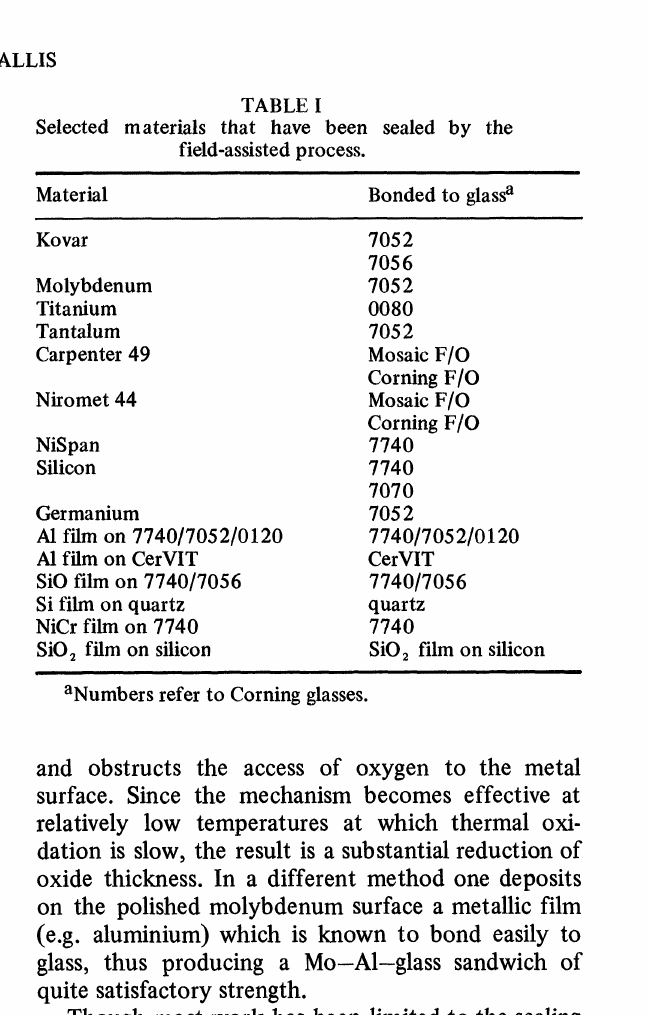
TABLE Selected materials that have been sealed by the field-assisted